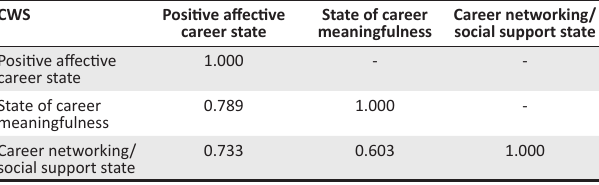
TABLE 3: Career Well-being Scale – Heterotrait-Monotrait ratio of correlations.